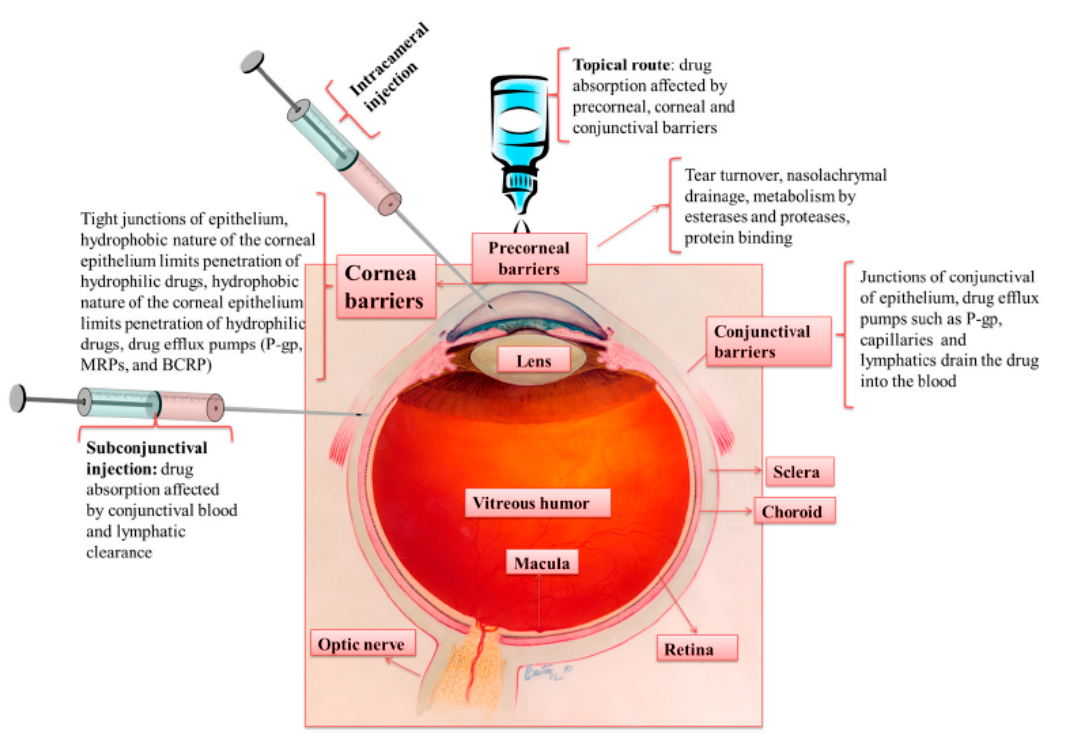
Figure 4. Routes of drug administration for anterior segment of the eye, clearance mechanisms and ocular tissue barriers that avoid drug absorption into the eye [40].